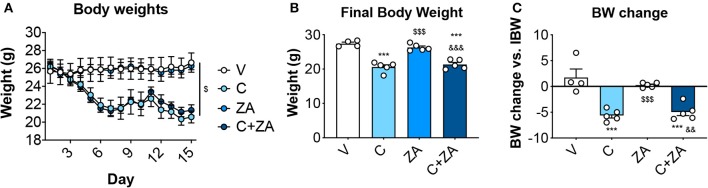
ZA fails to preserve body weight in cisplatin-treated mice. Body weight curves (A), final body weight (B) and body weight change (i.e., body weight at time of sacrifice vs. initial body weight) (C) in mice exposed to C, alone or in combination with ZA (n = 4–5). Control animals (V) were administered equal volumes of sterile saline. Data (means ± SEM) are expressed in grams. Significance of the differences: ***p < 0.001 vs. V; $$$p < 0.001 vs. C; &&p < 0.01, &&&p < 0.001 vs. ZA.